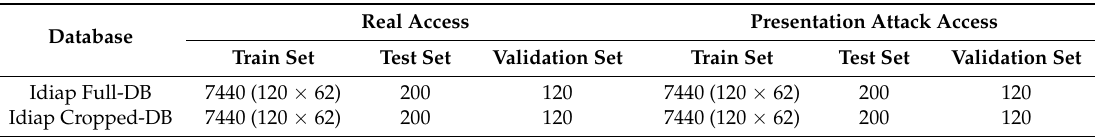
Table 8. Description of the augmented database derived from Idiap